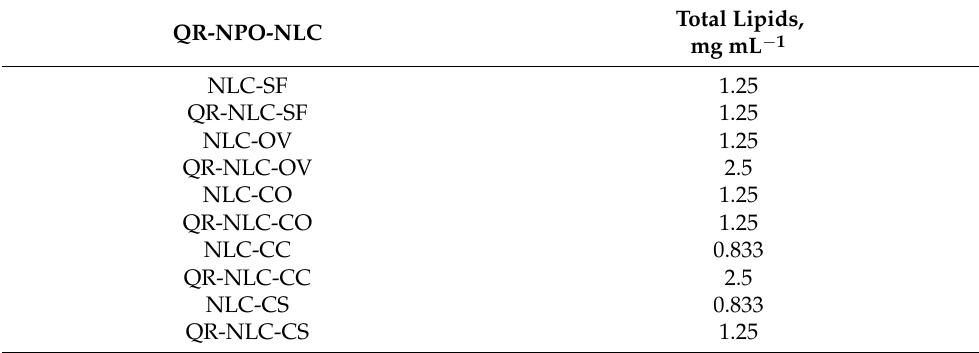
Figure 8. Cytotoxic effect of pure NPO, QR-NPO-NLC, and QR (2.5 mg mL − 1 in propylene glycol) on keratinocytes (HaCaT); dilution (D) 1/10, 1/20, 1/50, and 1/100; medium (DMEM) was used as comparison (positive control) (mean value ± SD; n = 3). Table 3. Non-toxic total lipid concentration (mg mL − 1 ) of NPO-NLCs in HaCaT cell lines expressed by amount of total lipid (mg mL − 1